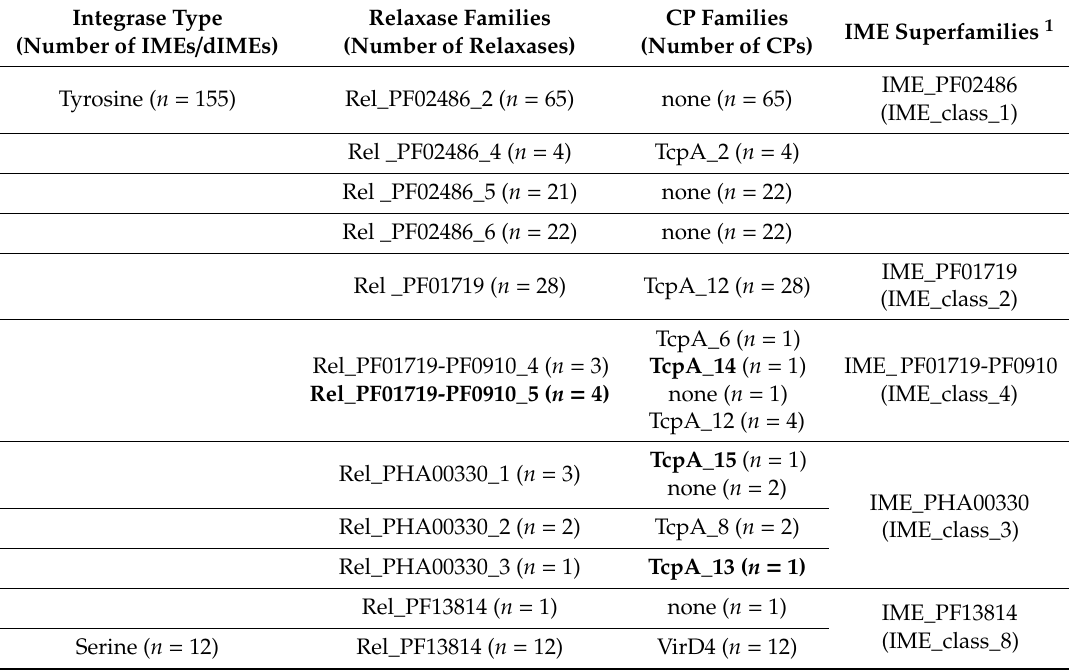
Table 1. Diversity of the relaxases and CPs associated with serine and tyrosine integrases in IMEs /